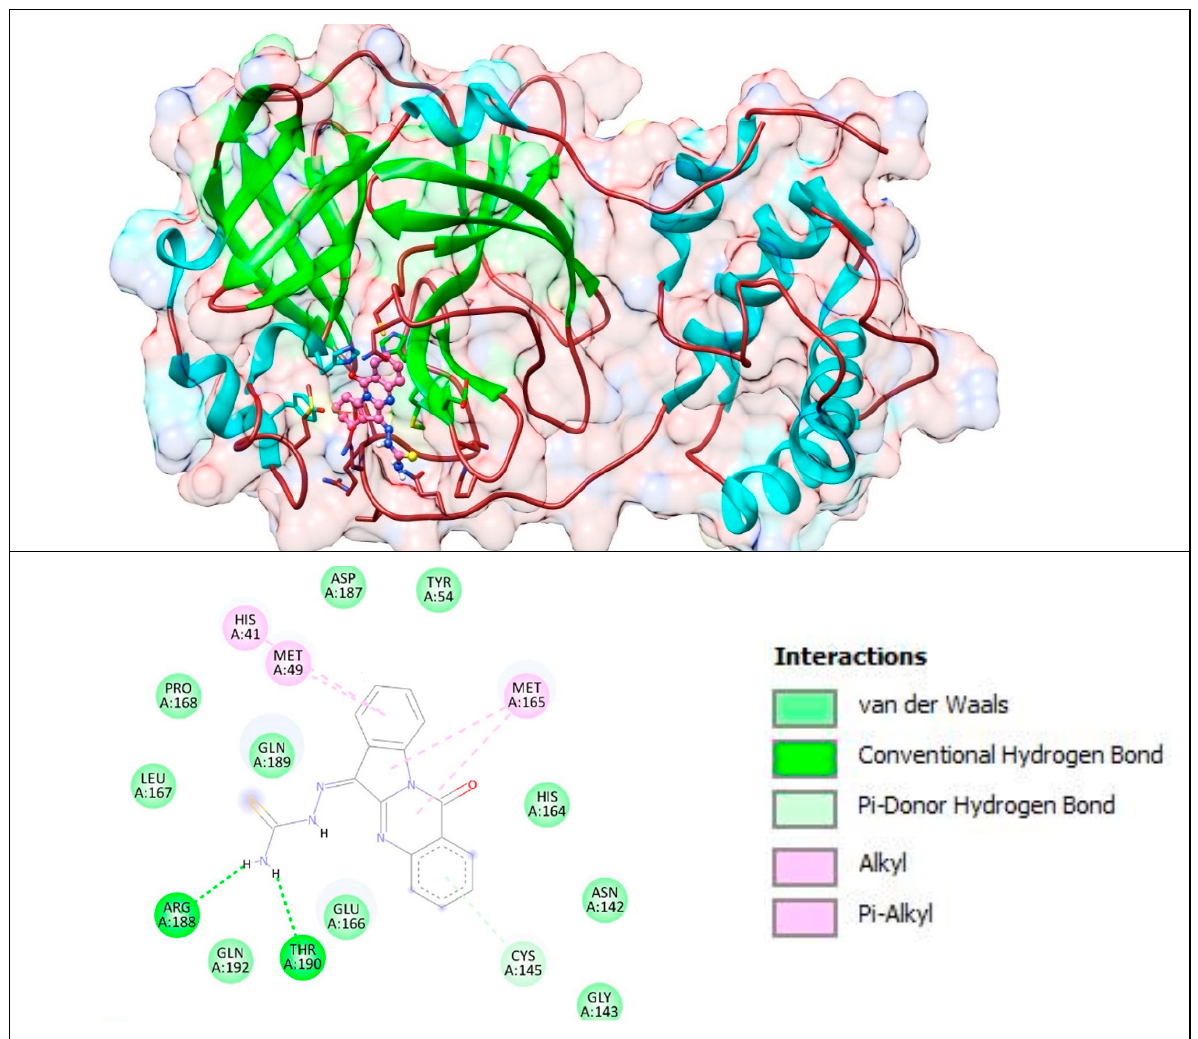
Figure 16. Complex of CoV-2 Mpro with T8H-TSC. The upper panel shows a 3D model of Mpro with a binding site (cavity) on its surface T8H-TSC. The lower panel shows the binding mode of the T8H-TSC compound with the amino acid residues of Mpro. Figure 16 was created with UCSF Chimera ( upper panel ) and BIOVIA Discovery Studio Visualiser ( lower panel ) and shows the best docking pose of T8H-TSC on Mpro. We can also see where T8H-TSC is placed on the Mpro surface and a general view of the complex of Mpro (green–cyan–brown) with T8H-TSC (pink). The secondary structure of the protease behind the molecular surface (created with 90% transparency to better illustrate the molecule) is also shown.